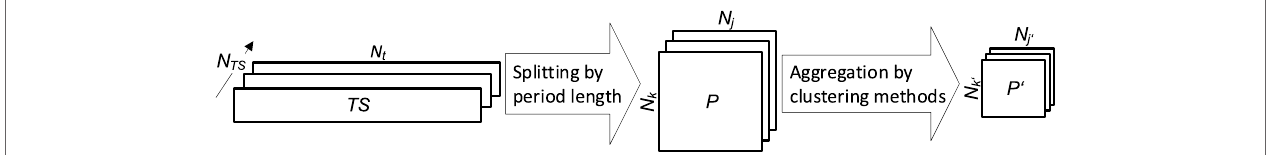
FIGURE 2 | All N TS original time series T S (left) with N t time steps each are splitted into N k periods P (middle) with a period length of N j segments each. Each period P still consists of N k · N j = N t time steps. Time-series aggregation to N k ′ typical periods P ′ (right) with N j ′ segments in each typical period, i.e., number of time steps reduced to N t ′ = N k ′ · N j ′ ≪ N t .